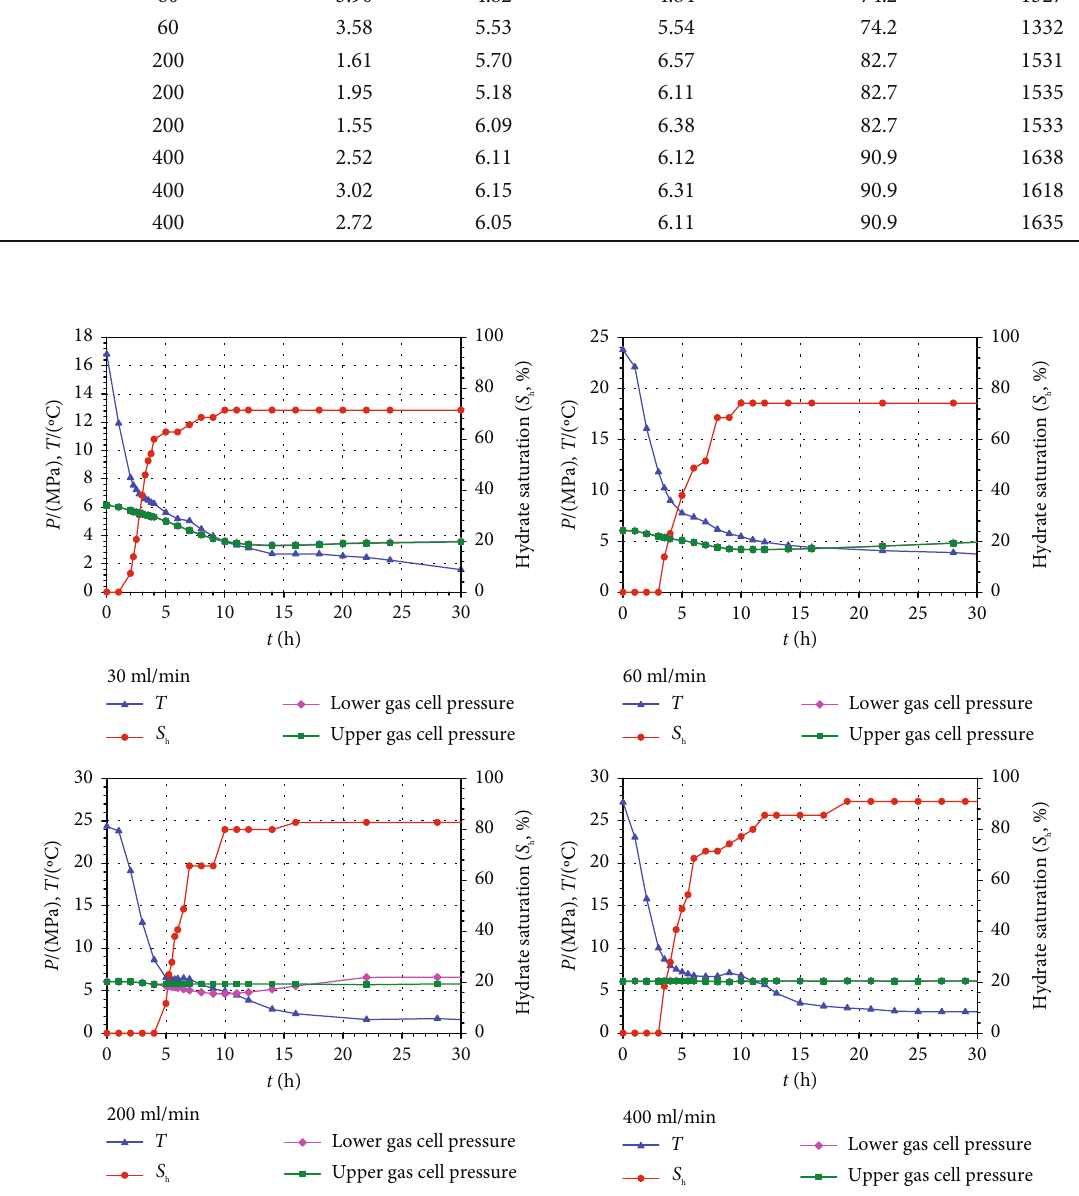
) during gas hydrate formation in di ff erent methane fl uxes (Data for h